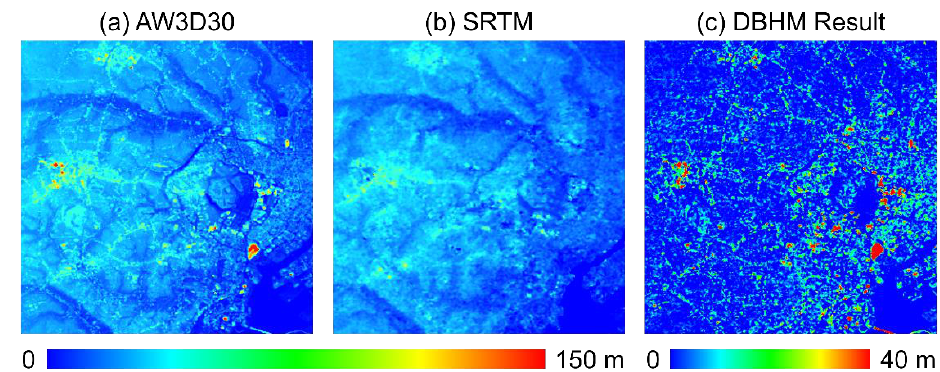
Figure 2. Materials and extraction result of Digital Building Height Model in Tokyo. ( a ) AW3D30 minus ( b ) SRTM equals ( c ) DBHM result.